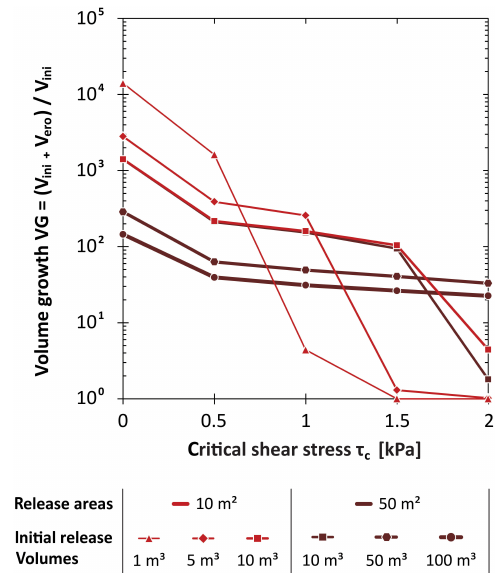
Figure 8. Sensitivity of the volume growth VG = ( V ini + V ero )/V ini to the critical shear stress τ c depending on five different initial (block release) volumes V ini as set up based on two release areas in the Meretschibach